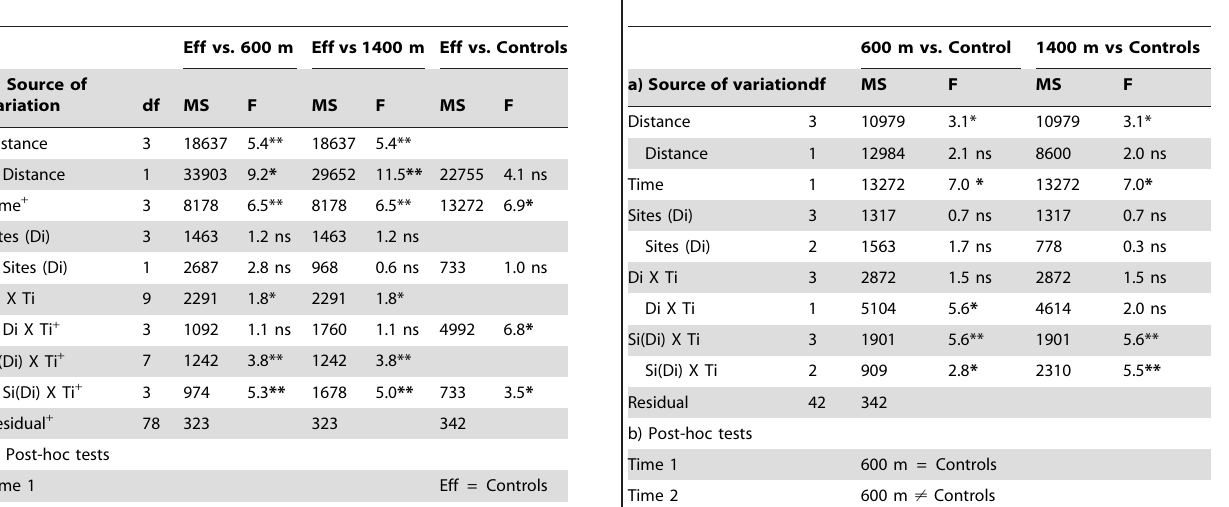
Table 6. Asymmetrical multivariate analyses on the structure of assemblages in different sites in all sampling times.